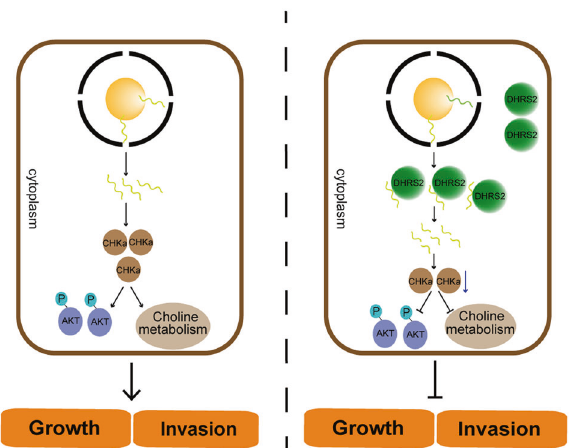
Fig. 7 Schematic illustration of DHRS2 inhibiting OC growth and invasion by regulating choline metabolism. Left, CHK α mRNA is translated to protein, which promotes the activation of choline metabolism and AKT pathway, thereby promoting the growth and invasion of OC. Right, DHRS2 can directly bind to CHK α mRNA to accelerate its degradation. Correspondingly, CHK α protein expres- sion is downregulated, resulting in the disruption of choline metabolism and AKT signaling. These effects lead to the inhibition of OC growth and metastasis. OC, ovarian